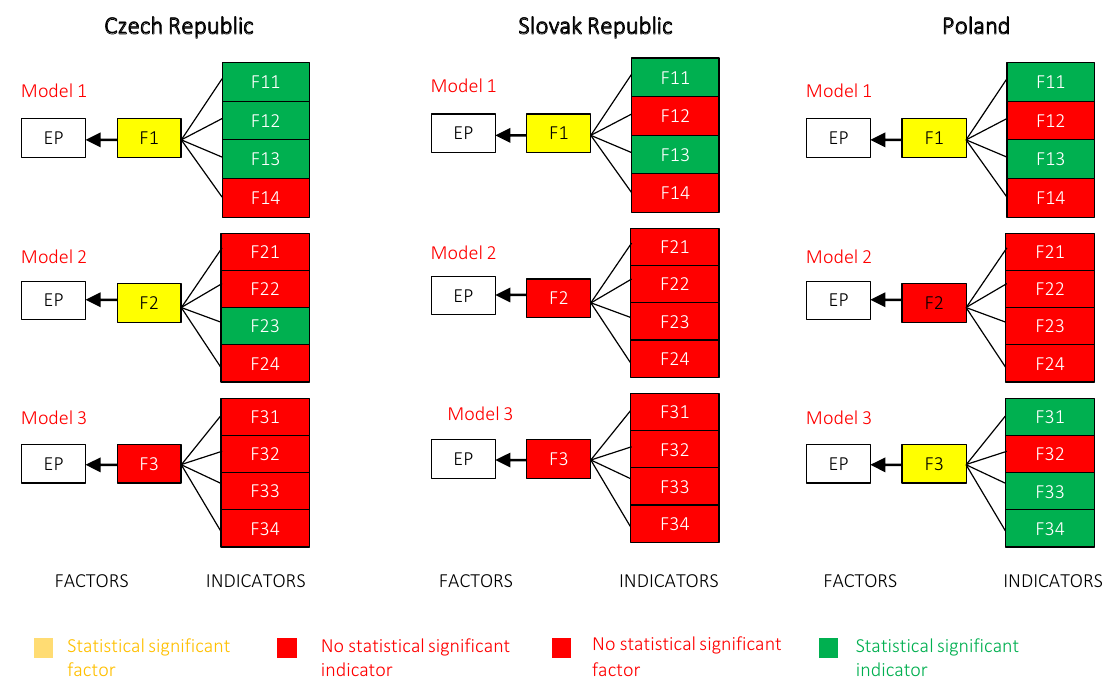
Figure 2. Results of partial regression